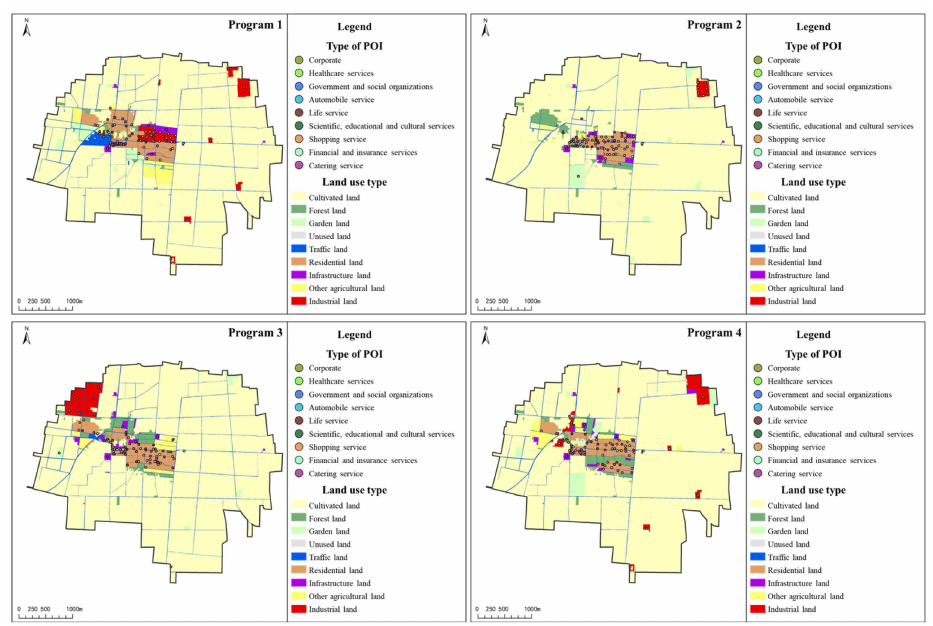
Figure 4. Alternative planning programs for Zepan